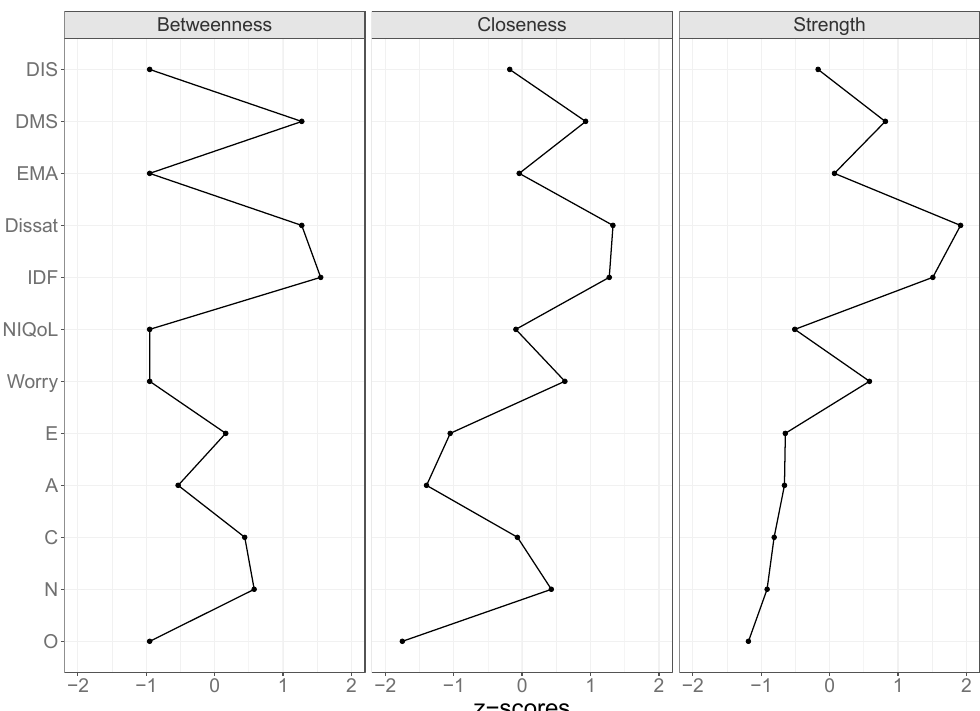
Figure 4. Standardized scores on the centrality measures of the personality traits and the ISI item scores. Abbreviations: Worry = Worry about sleep, NIQoL = Noticeability of Impaired Quality of Life, IDF = Interference with Daily Functioning, Dissat = Dissatisfaction with sleep, EMA = Early Morning Awakening, DMS = Difficulty Maintaining Sleep, DIS = Difficulty Initiating Sleep, A = Agreeableness, C = Conscientiousness, E = Extraversion, N = Neuroticism, O = Openness. The plots show that the ISI items Dissat and IDF are the highest on the centrality measures. IDF lies on the shortest path between two other nodes most often ( Betweenness ), while Dissat has the smallest overall distance to all other nodes ( Closeness ), and is connected the strongest to its direct neighbors ( Strength ).